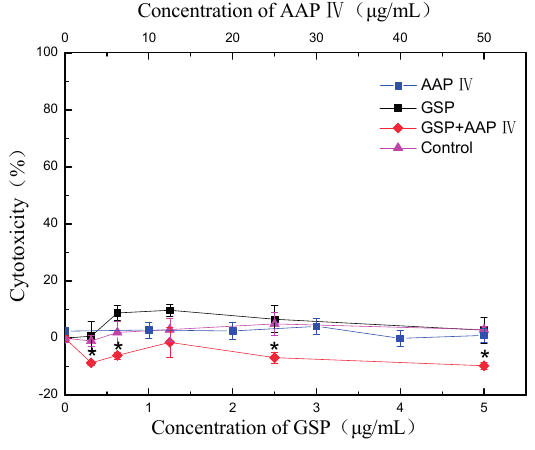
Figure 3. Effect of GSP, AAP, and their combination on cytotoxicity of splenocytes. * indicates a significant difference from the control ( p <